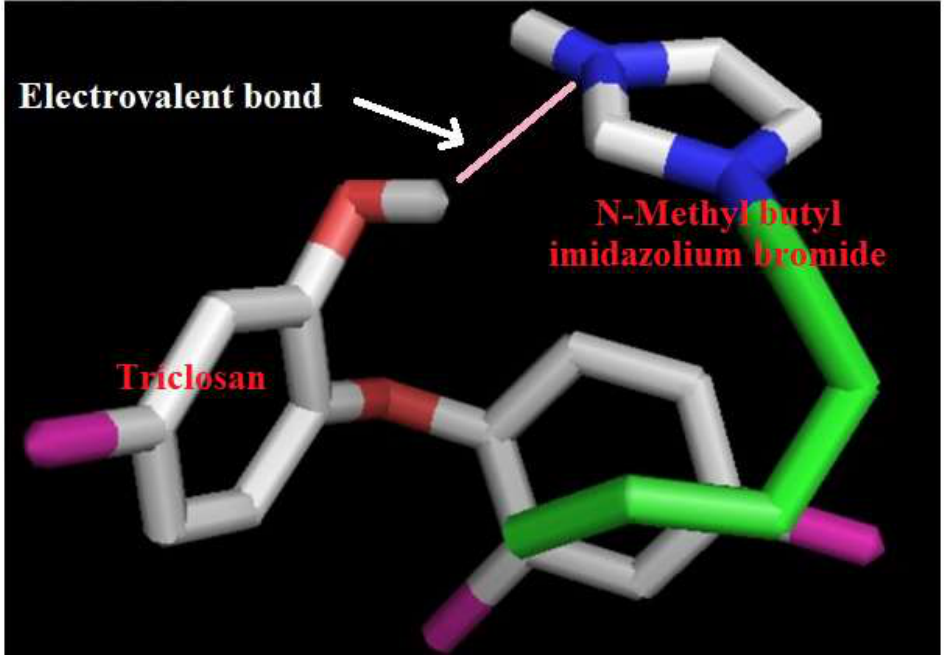
Figure 8. Interacting model of triclosan with N-methyl butyl imidazolium bromide.